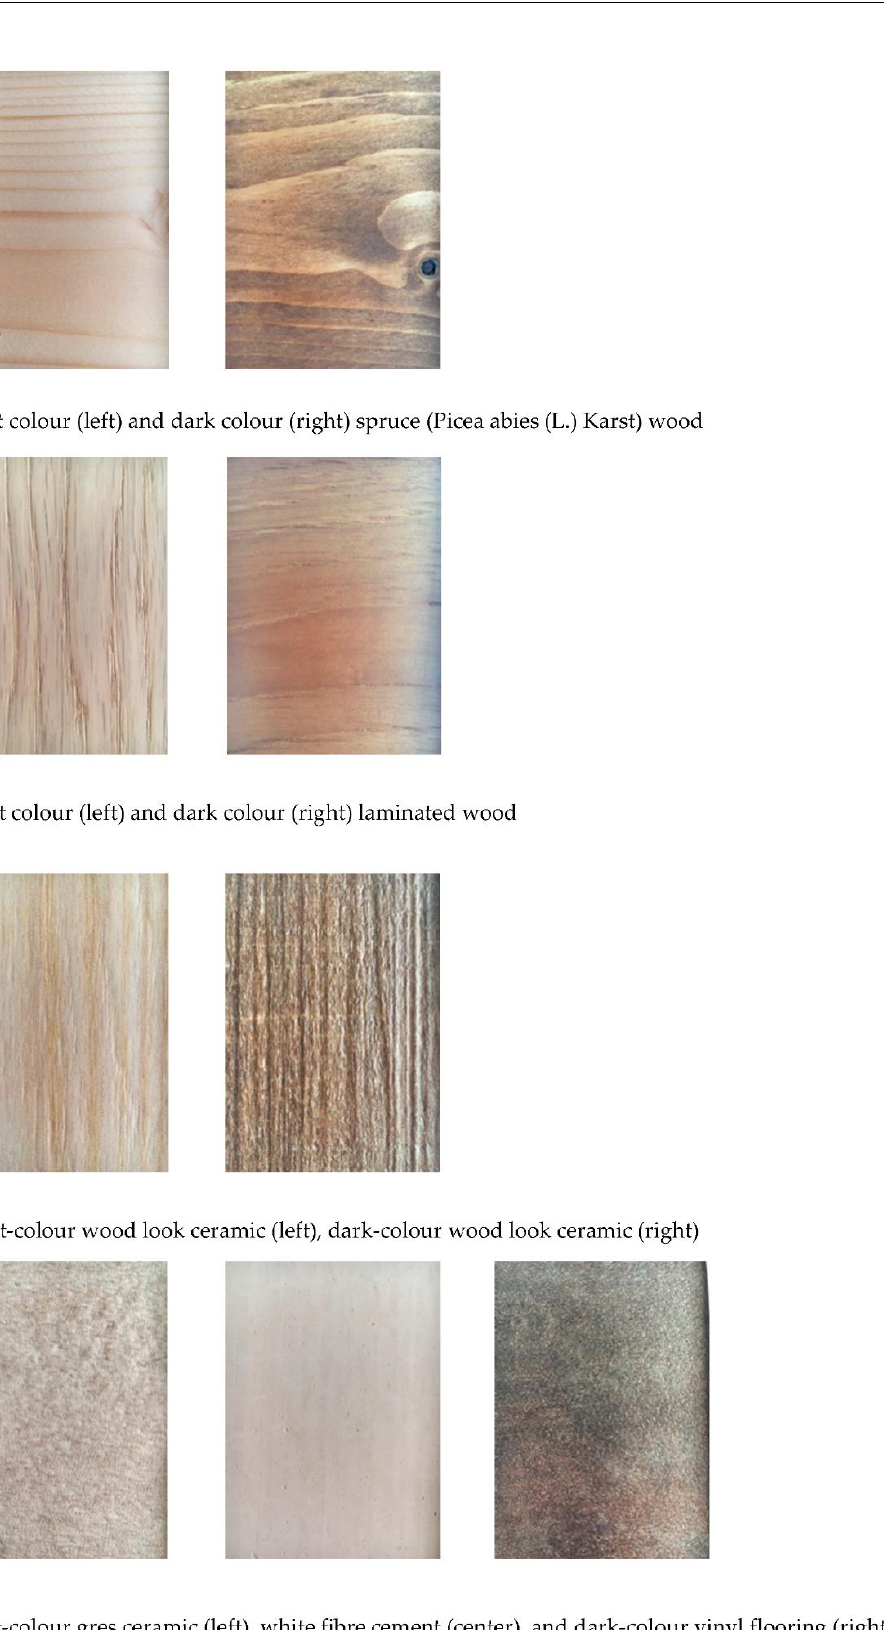
Figure 1. The nine building materials used as target stimuli to assess the perception and evaluation of building materials.